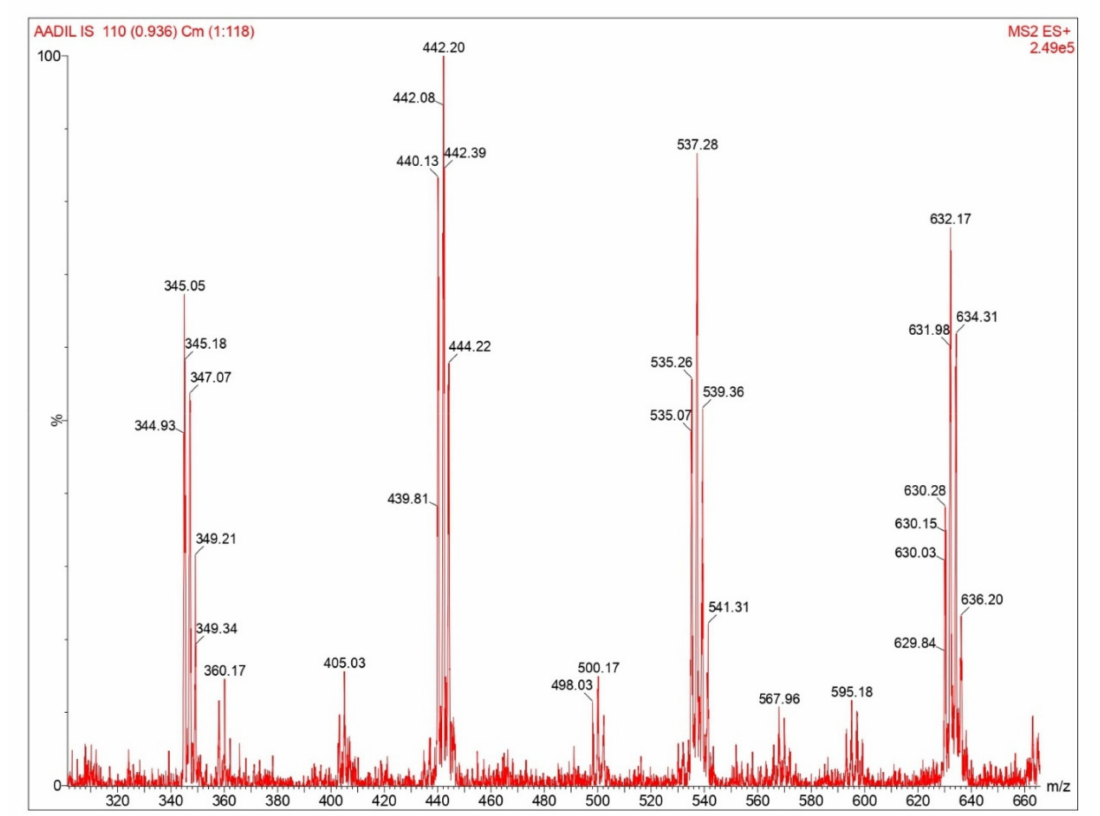
Figure 2. Spectral representation of signature peptides for trastuzumab